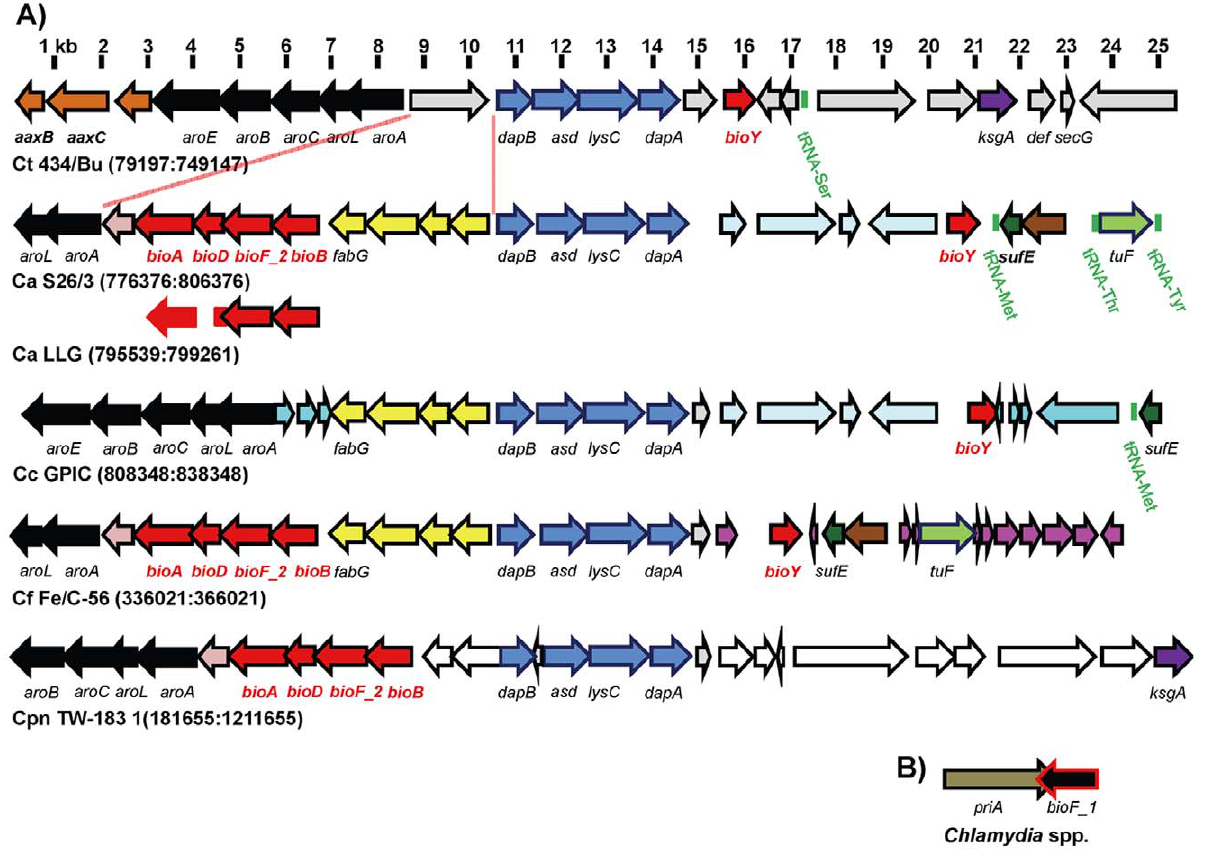
Figure 3. Genome synteny analysis of Chlamydia biotin synthesis and transport genes. Representative chlamydial genomes were anchored at the dapB - dapA gene cluster (in blue) and aligned using the Genome Region Comparison tool from JCVI CMR and NCBI genome (panel A). Genome scale is shown at the top of panel (A). Conserved gene clusters are shown in similar color. Biotin synthesis and transport genes are shown in red. In panel B, the pan-chlamydial genome location of bioF_1 relative to priA is shown. The species/strains used and genome regions depicted are listed below each genome plot (Ct: C. trachomatis , Ca: C. abortus , Cc: C. caviae , Cf: C. felis , Cpn: C. pneumoniae ). For C. abortus LLG, only the biotin synthesis gene operon is shown ( bioADF_2B ). The region of biotin synthesis gene insertion is shown with red lines below Ct 434/Bu.